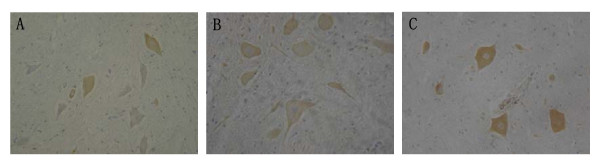
Effects of TMP on Bax expression in spinal cord at the 48th hour reperfusion. Immunohistochemical photomicrographs (magnification × 400) of anterior horn tissue stained for Bax protein in sham group (A), control group (B) and TMP group (C). Immunostaining was performed using a specific anti- Bax antibody and developed with stable DAB. The positive staining of Bax is presented by a brown color of cytoplasm. Figures are representative of 3 separate experiments with similar results.